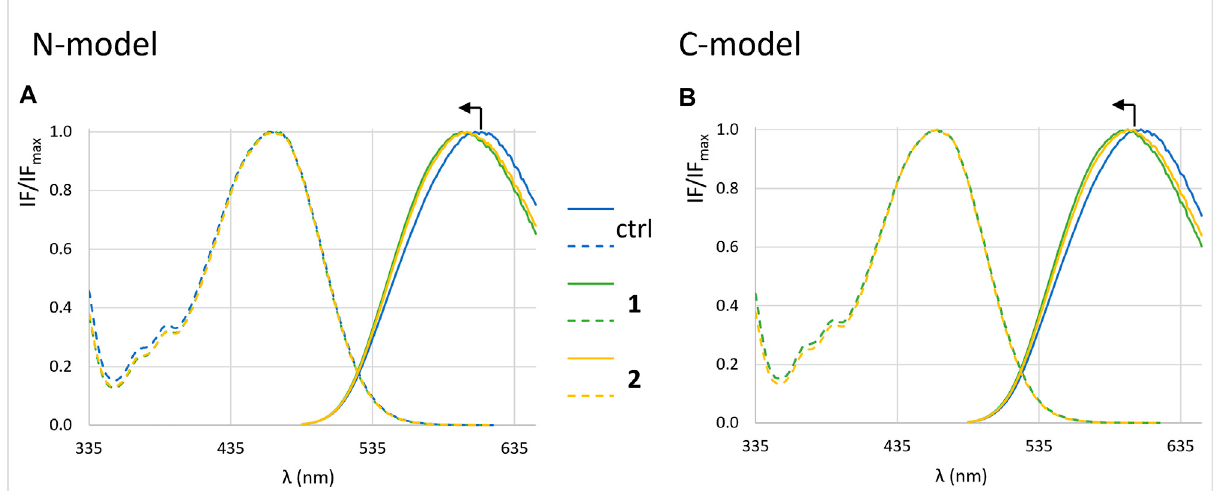
FIGURE 9 Fluorescence spectra of di-4-ANEPPS. Normalized excitation (dashed lines) and emission spectra (full lines) in the absence (blue) and in the presence of 1 (green) and 2 (yellow) in LUVs corresponding to N-model (A) and C-model (B) after 1 h incubation in buffer 3